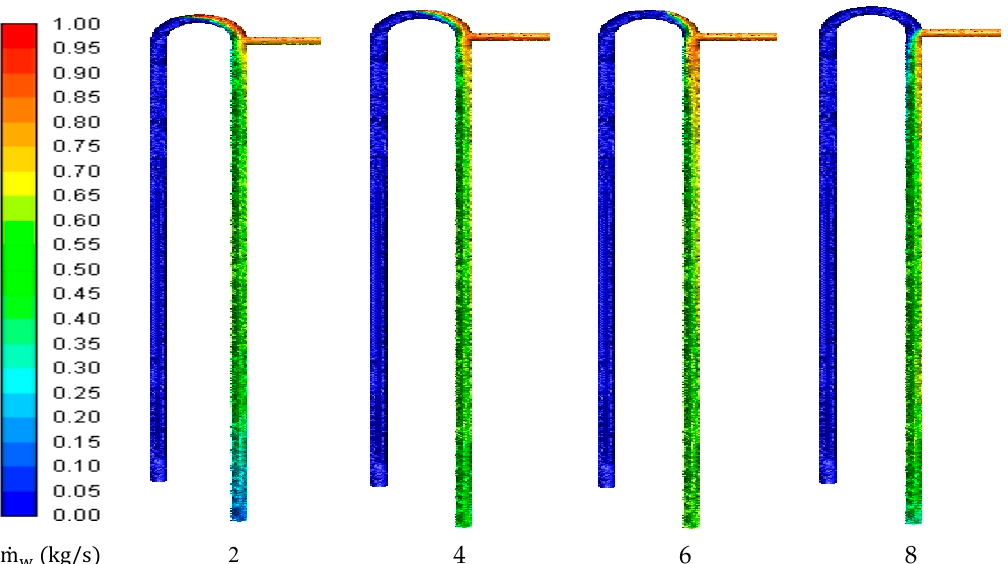
Figure 16. Air volume fraction contours at different flow ratios and X (cid:2933) = 461.42, α (cid:2923) = 0.7 , X (cid:2932) = 0.1.